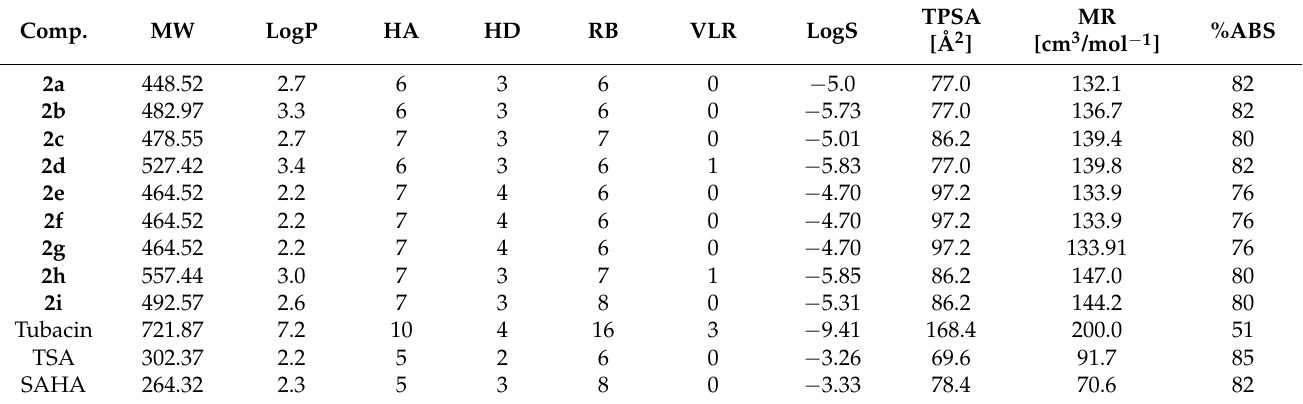
Table 1. Physicochemical properties of 2a – i and prediction of oral absorption (%ABS) compared with the reference compounds (tubacin, TSA, and